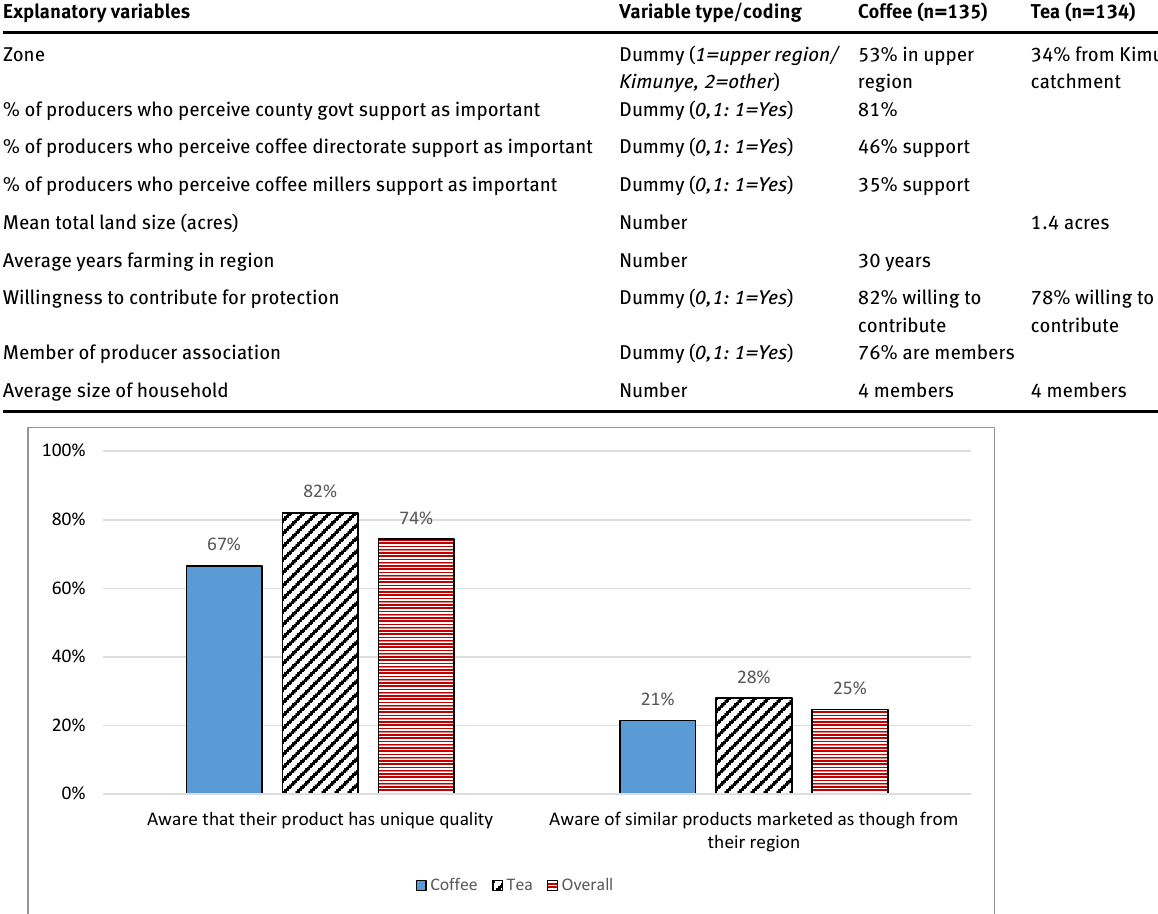
Table 1: Description of producer related variables and attitudes influencing income Explanatory variables